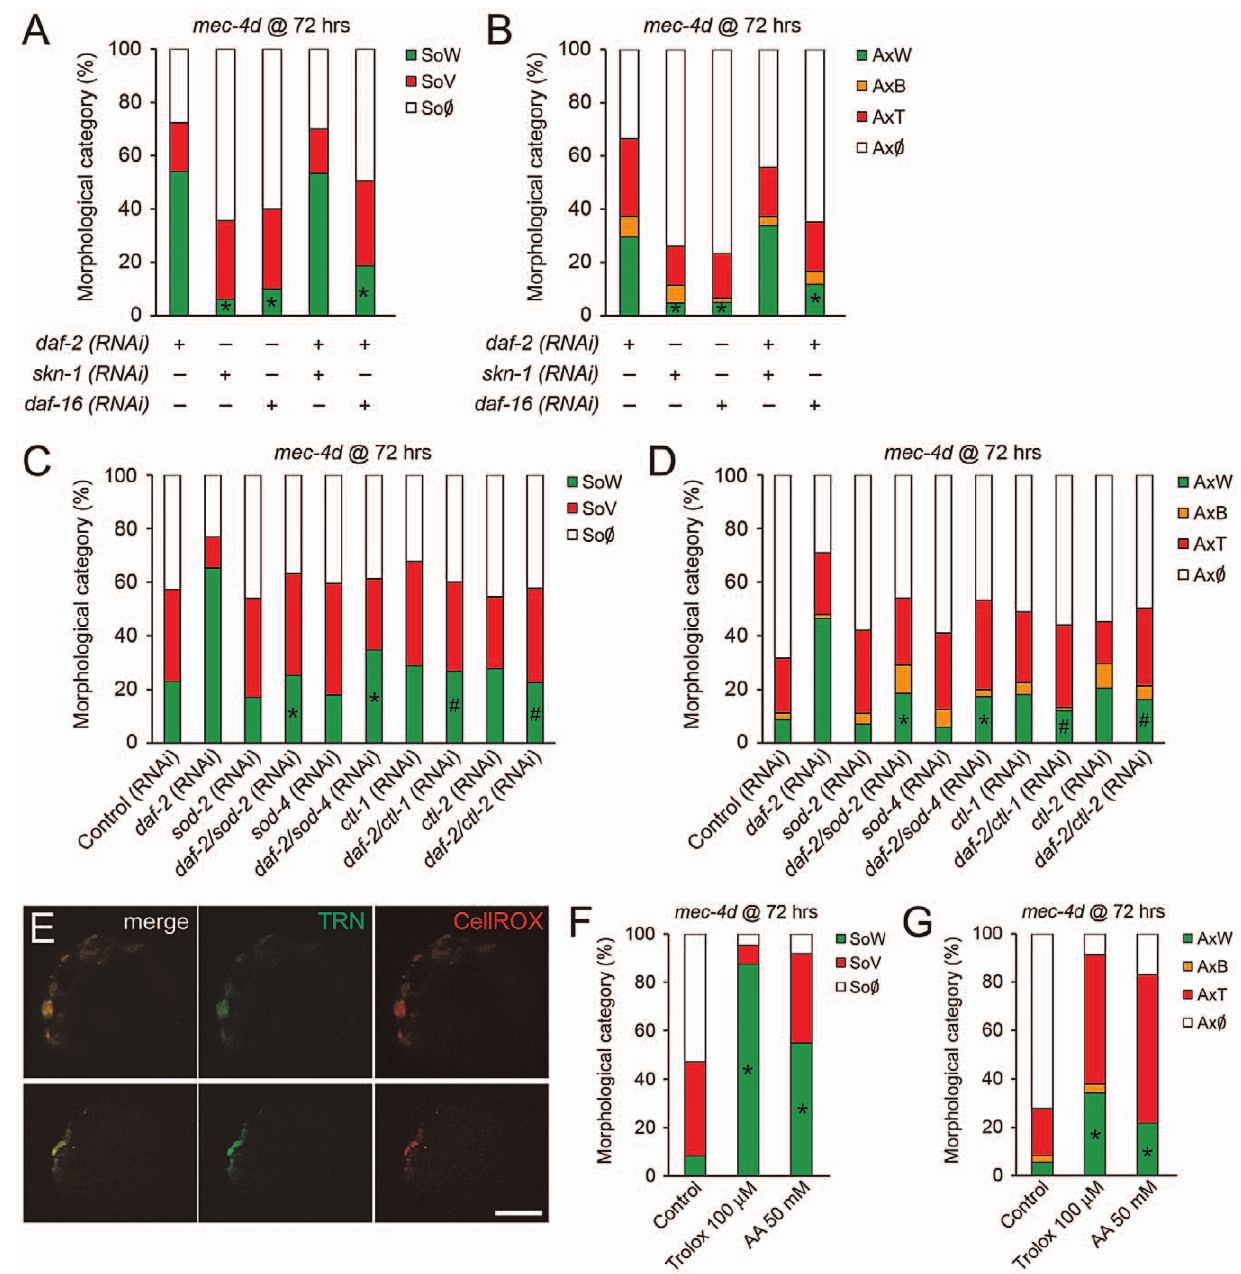
Figure 5. DAF-16 contributes to inhibition of mec-4d –dependent AVM degeneration associated with reduced IIS signaling. (A–B) Double RNAi experiments in the TRN-autonomous RNAi strain carrying the mec-4d(e1611) mutation (WCH6) were performed to assess the role of DAF-16 and SKN-1 downstream DAF-2 in the protection of AVM neurons. In both somas (A) and axons (B), single daf-2(RNAi) , but not skn-1 or daf-16 , protects the AVM neuron from degeneration. When combined, only daf-16(RNAi) is able to revert the protective phenotype given by daf-2(RNAi) (mean value for each category is shown; error bars [ , 0.1%] are not included; N=3 of 30 worms each per group; *p , 0.05 by Student’s t test compared to single daf-2(RNAi) for the SoW and AxW category). (C–D) Combinatorial RNAi experiments were performed to address the role of endogenous antioxidant enzymes. daf-2(RNAi) together with either sod-2 , sod-4 , ctl-1 or ctl-2 were fed to the TRN-autonomous RNAi strain carrying the mec-4d(e1611) mutation (WCH6). All double RNAi significantly decreased the daf-2(RNAi) protection of degeneration of somas and axons of the AVM neuron. (E) ROS was visualized using the fluorogenic dye CellROX (red) in mec-4d embryos. A strong signal of the dye co-localized with the endogeneous GFP expressed by degenerating TNRs. Scale bar, 5 m m. (F–G) mec-4d worms were treated from the time of hatching with the ROS scavenger trolox (100 m m) and ascorbic acid (AA, 50 mM); after 72 hours both somas (F) and axons (G) were protected several fold compared to control nematodes (mean value for each category is shown; error bars [ , 1%] not included; N=3 of 30 worms each per group; *p , 0.005 by Student’s t test compared with control for the SoW and AxW category).